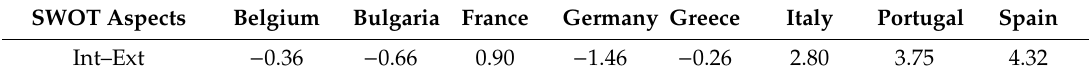
Table 5. Internal–external SWOT